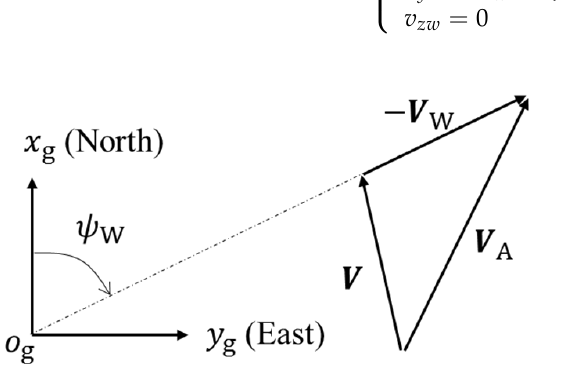
, ground speed 𝑽 , and airspeed 𝑽 𝐖